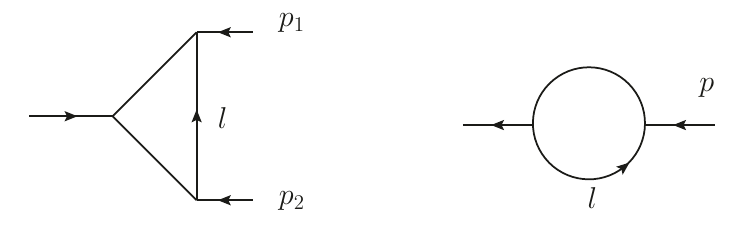
Figure 3 . Orientation for external and loop momenta used in the integral reduction